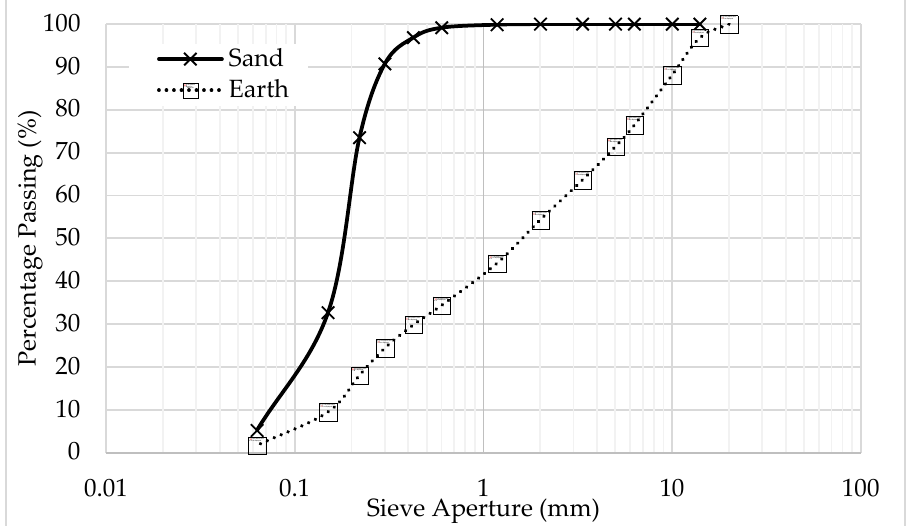
Figure 1. Grain size distribution of earth and sand.